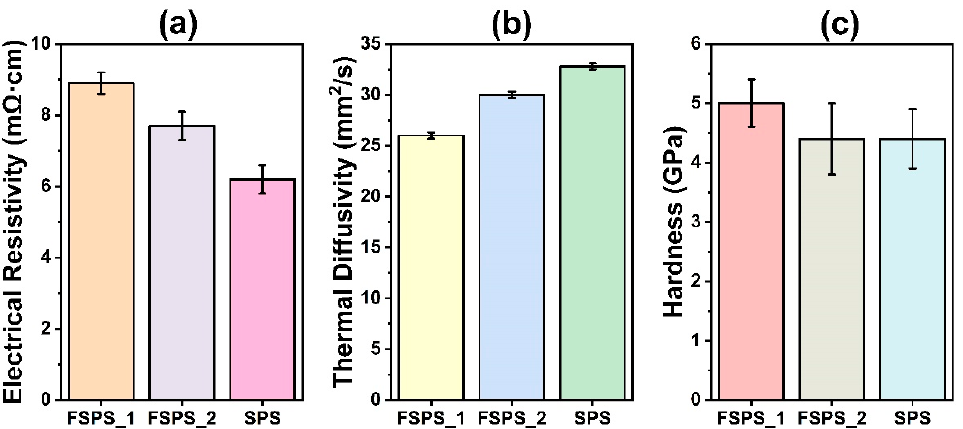
Figure 10. Properties of the samples fabricated under different processing conditions: ( a ) electrical resistivity; ( b ) thermal diffusivity; ( c ) hardness.